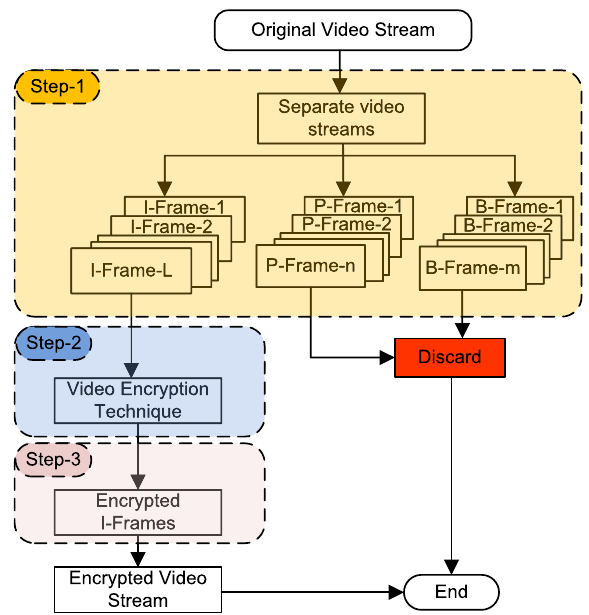
Fig. 1 Framework of video encryption